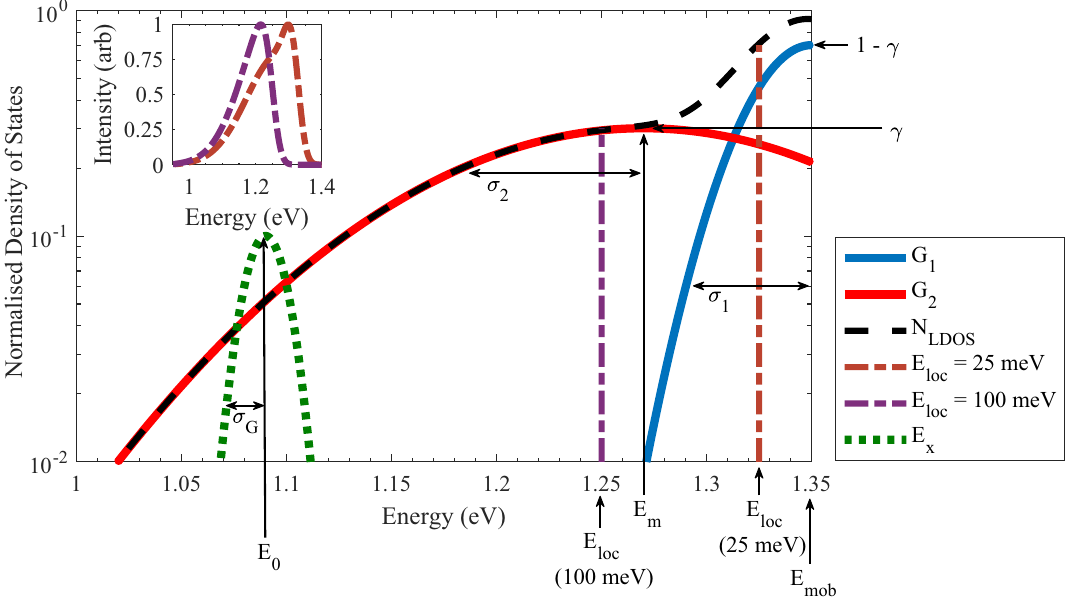
Figure 1. Example LDOS profile produced from Eq. (1). The overall profile (dashed line) is a summation of G1 and G2 (solid lines) which are produced from Eq. (2). Arrows have been added to indicate the meaning of each of the parameters in Eq. (1). Example localisation energies (dot-dashed lines) have been added to indicate the effect of N LDOS on the model output PL (inset) after being convolved with E x (dotted green